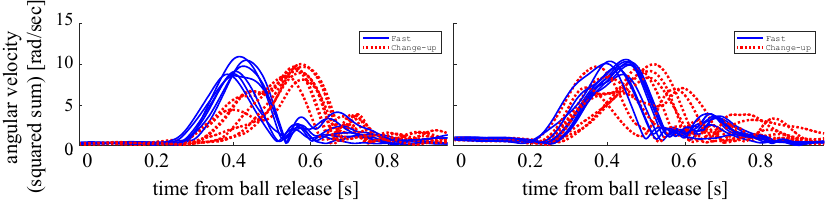
Figure 2. Trajectories of the squared sum of angular velocity components of pelvis (left: top batter (unknown), right: young batter